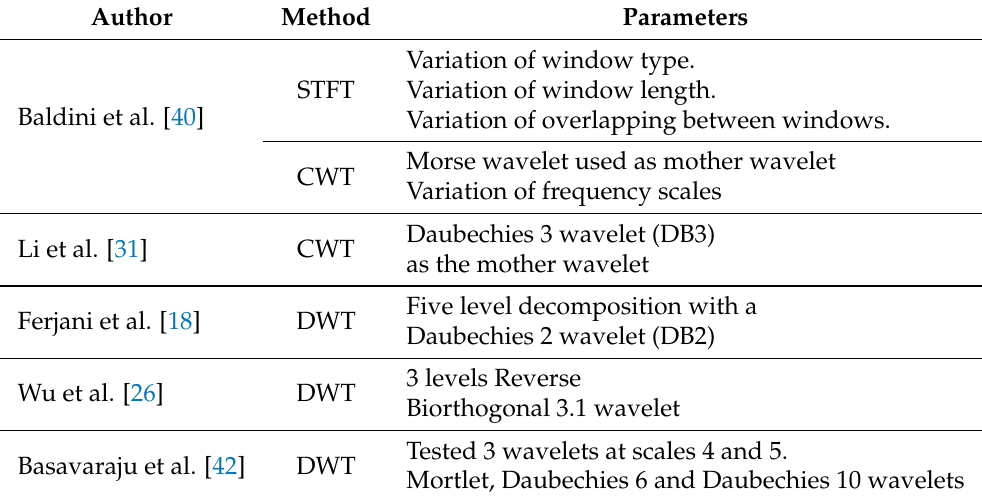
Table 8. Time-frequency methods used to extract features from inertial sensors for the detection and classification of road surface